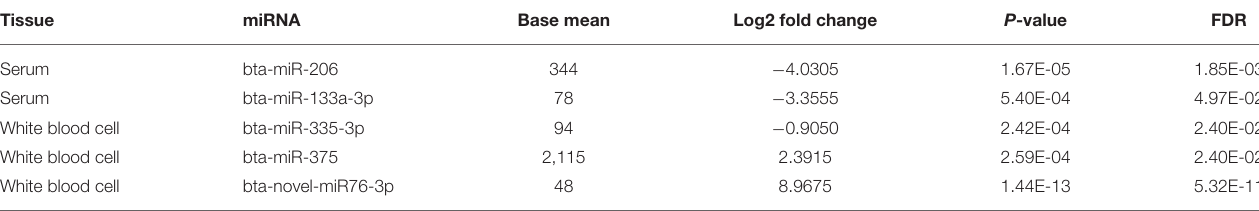
TABLE 2 | Differentially expressed miRNAs in serum and white blood